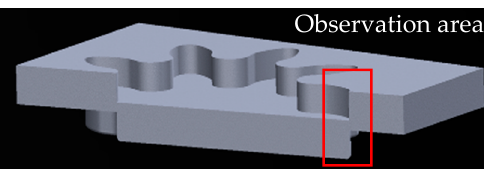
Figure 8. Observation area of microgear for electron back-scatter diffraction (EBSD) analysis.